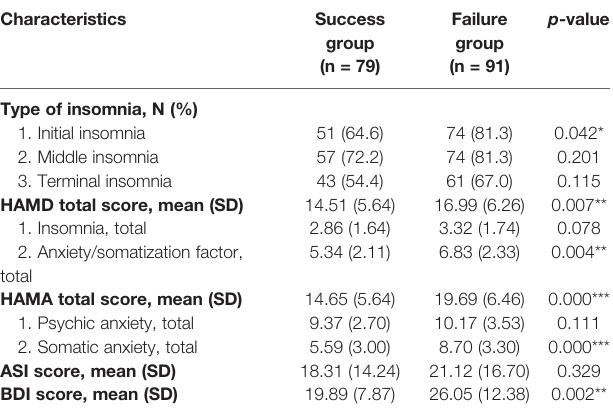
TABLE 2 | Type of insomnia, depression and anxiety symptoms. Characteristics